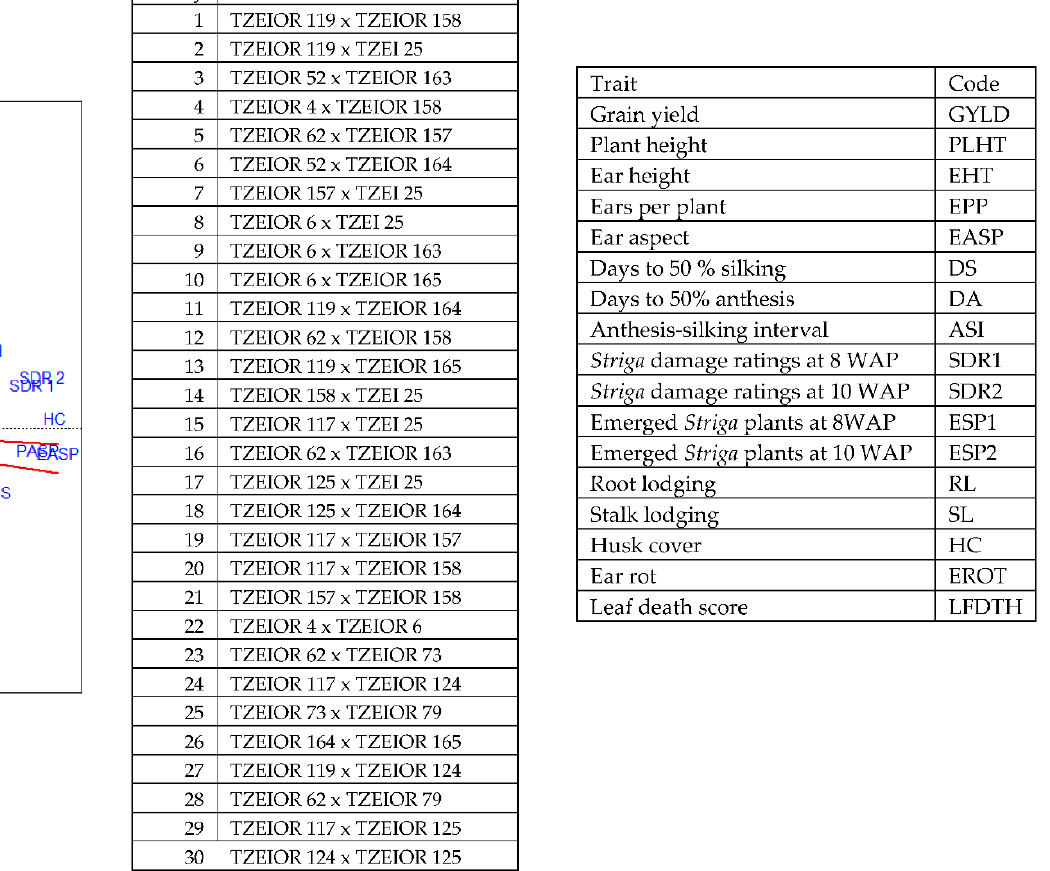
Figure 5. A polygon view of genotype by trait showing top 20 hybrids and the least 10 hybrids among the 196 testcrosses evaluated under Striga infestation at Mokwa and Abuja, drought stress at Ikenne and low N at Mokwa and Ile-Ife, Nigeria in 2016 and 2017. The biplot was based on genotype-focused singular value partitioning (‘SVP = 2). Principal component (axis 1) and axis 2 for model 2 explained 70.34% of the variation among traits.